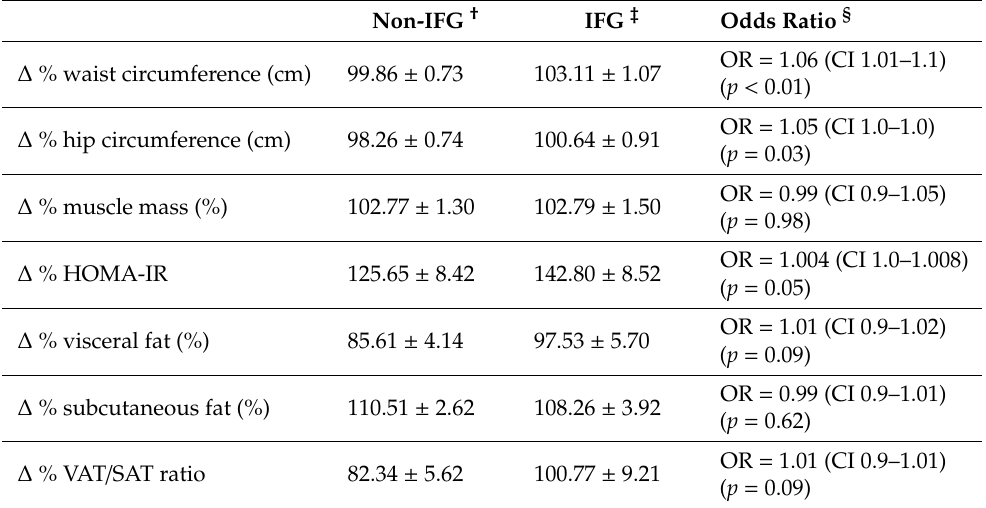
Table 3. Descriptive statistics, odds ratios (OR), and corresponding p -values in the prospective study estimated using age-adjusted generalized linear models with the logit link function.